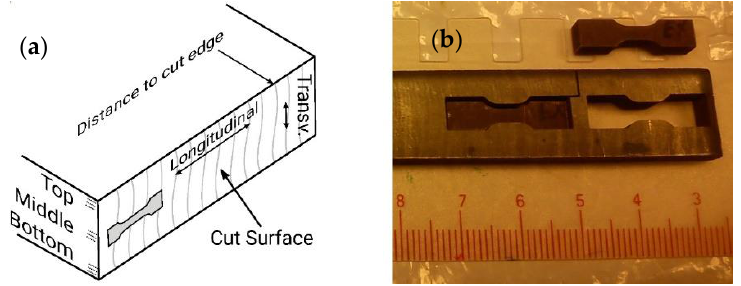
Figure 1. ( a ) General geometry of the cut plate including the orientation of tensile specimens, zones where hardness measurements were made, and directions used for measuring stresses. ( b ) Extraction of four bone shaped blocks (for later slicing and extraction of the mini-tensile samples), by electro-erosion of the central zone of the cut edge. Scale shown is in millimeters.